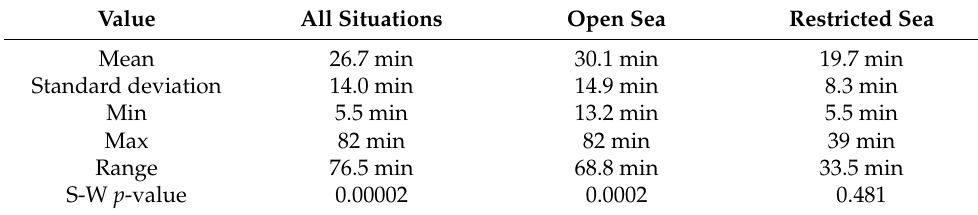
Table 4. Basic statistics for the TCPA at the start of the manoeuvre.